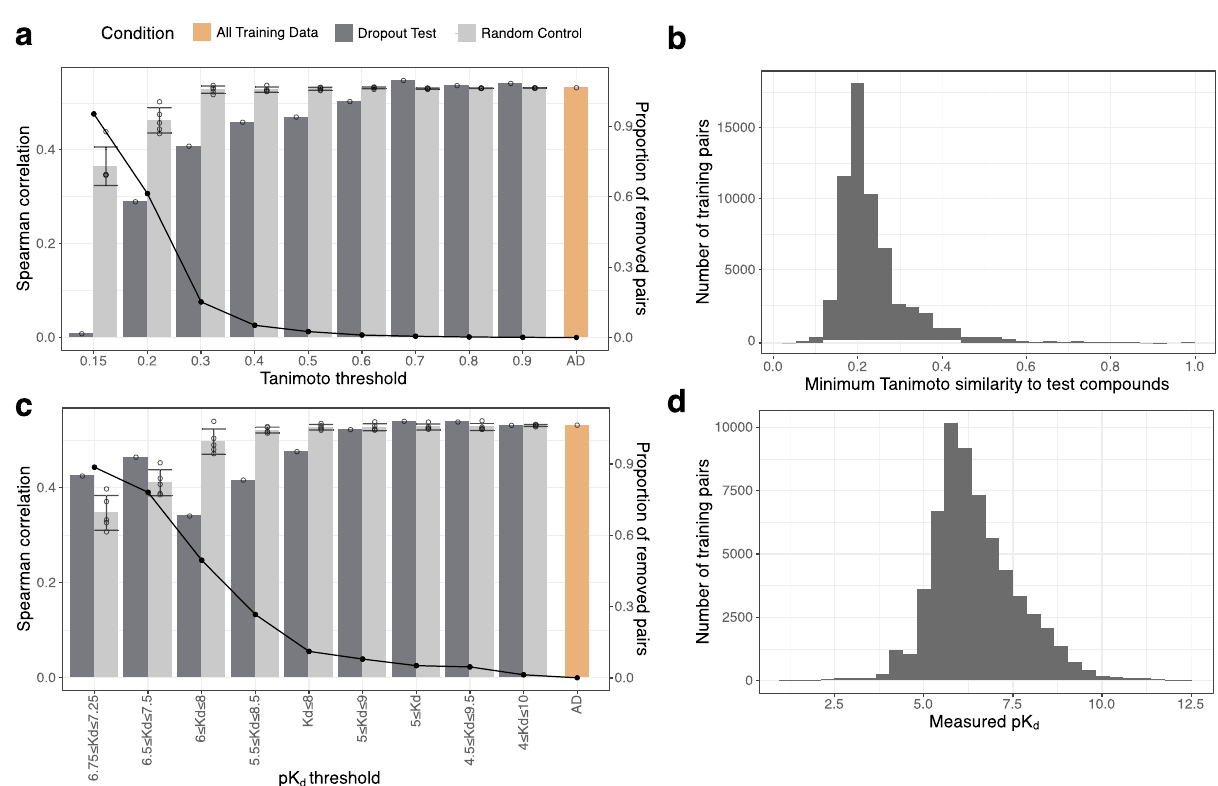
Fig. 5 The Q.E.D model performance as a function of training data size and scope. a The drop-out experiment removed increasing numbers of training compounds (as measured by maximum Tanimoto similarity with ECFP4 fi ngerprint between each training compound and all Round 2 test set compounds), retrained the Q.E.D model, and tested the performance. AD stands for all data. A noticeable decrease in performance begins to appear only at around 0.6 Tanimoto similarity suggesting that highly similar compounds in the training dataset are not necessarily required for accurate model performance. As a control, identical numbers of random compound-kinase pairs were removed, repeated 5 times to assess the variability of random removal. The error bars indicate the standard deviation of these replicates. Black points indicate proportions of removed compound-kinase pairs. b A histogram describing the full training dataset used to generate the results in a . c Model performance with multiple training datasets and varying pK d levels, where the ranges in the x - axis labels refer to the compound-kinase pairs that were included for the model training. AD stands for all data. Random dropout control was repeated 5 times. The error bars indicate the standard deviation of these replicates. d A histogram describing the full training dataset used to generate the results in c . Source data are provided as a Source Data fi le 54